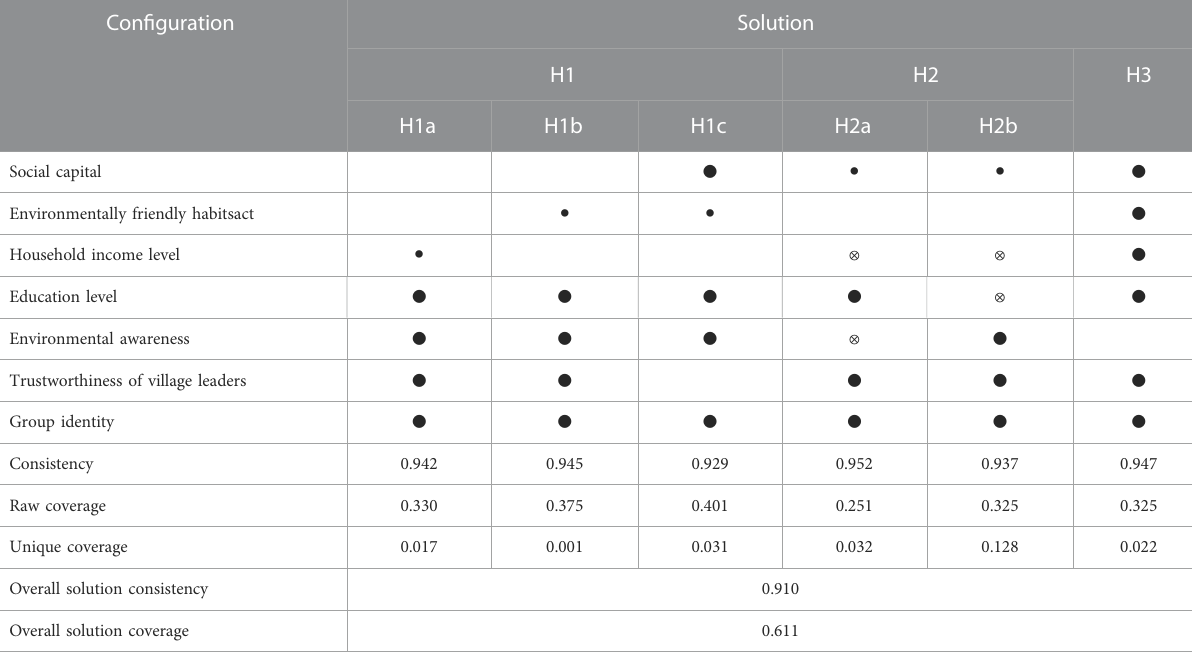
TABLE 3 Paths of high-level willingness grouping of rural households to participate in improving their living